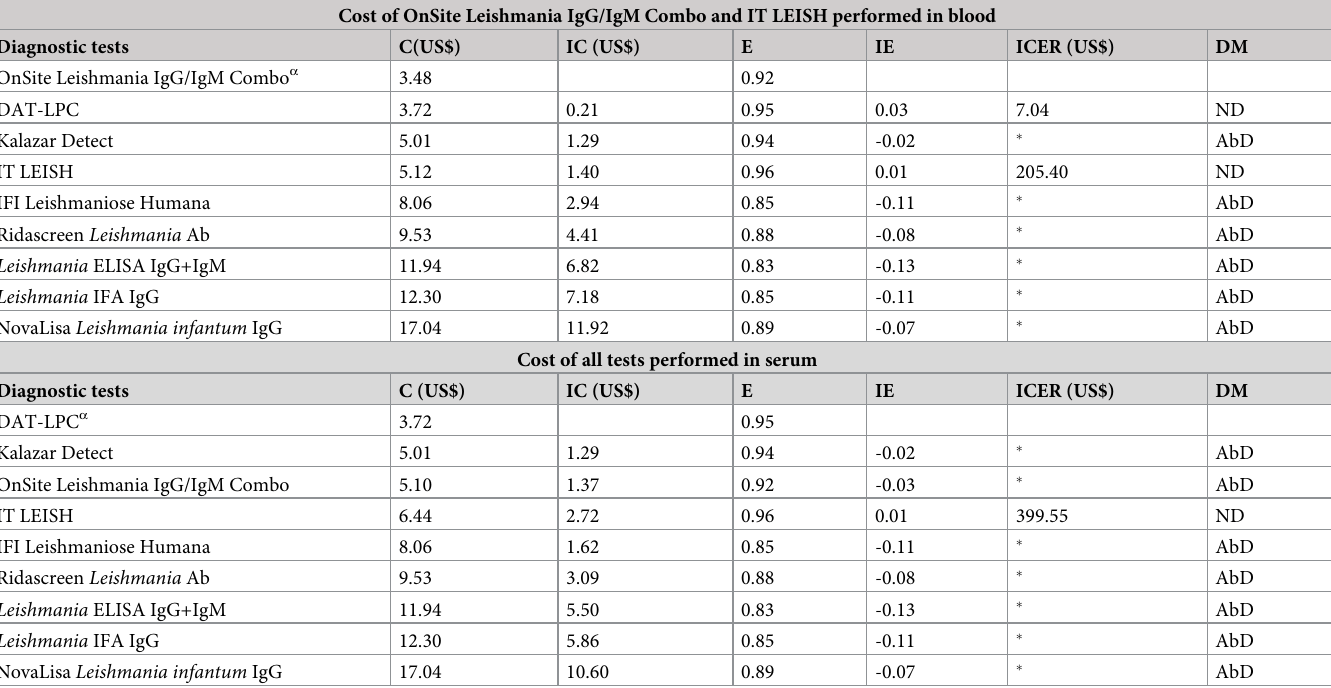
Table 3. Cost-effectiveness analysis of diagnostic tests for visceral leishmaniasis for HIV-uninfected patients. Cost of OnSite Leishmania IgG/IgM Combo and IT LEISH performed in